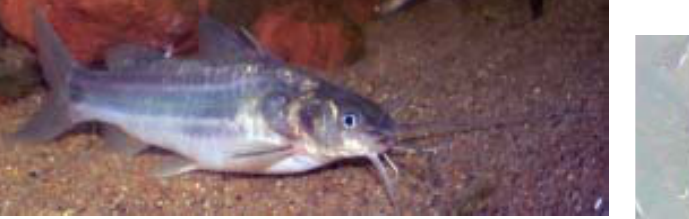
14. Striped Dwarf Catfish Mystus vittatus